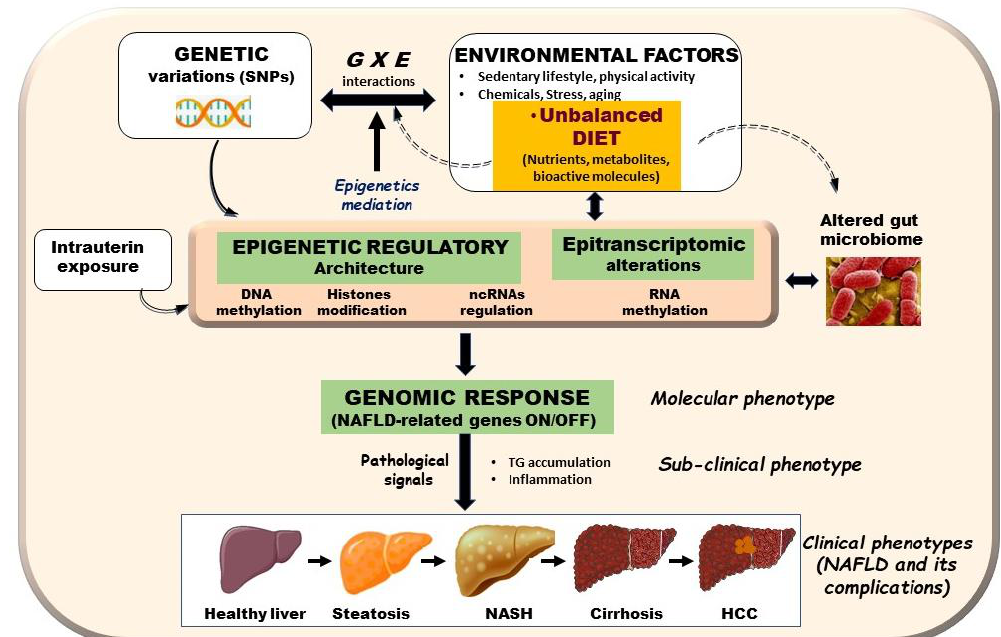
Figure 1. Schematic representation of potential epigenetic and genetic events that are altered by diet leading to NAFLD- related genes aberrant expression. Environment factors ( E ) such as nutrition, genetics factors ( G ), gut microbiota, and intrauterine environment, act collectively in play with epigenetic landscape to induce NAFLD phenotype and associated complications. Diet represents one of greatest environmental determinants of an individual’s health. Nutrients, metabolites, and bioactive components can reversibly alter epigenetics marks causing epigenetics alterations in known epigenetic mech- anisms: DNA methylation, histone modifications, noncoding RNAs regulation, and most likely, RNA epigenetics. Resulting epigenetic alterations impact genome by affecting metabolic gene expression patterns, and accordingly, lead to metabolic diseases such as NAFLD. These events highlight role of epigenetic alterations as interface between E (e.g., diet/metabolism) and G (e.g., genetic variations) interactions in metabolic disorders including